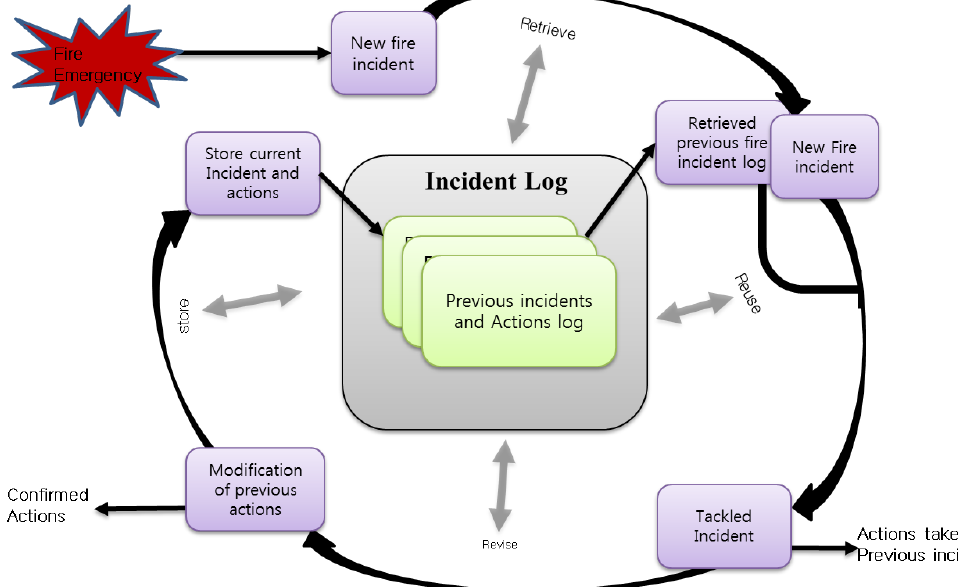
Figure 8. Log-based emergency fire management cycle shows the method to handle the emergency situation and store current incident logs in the log